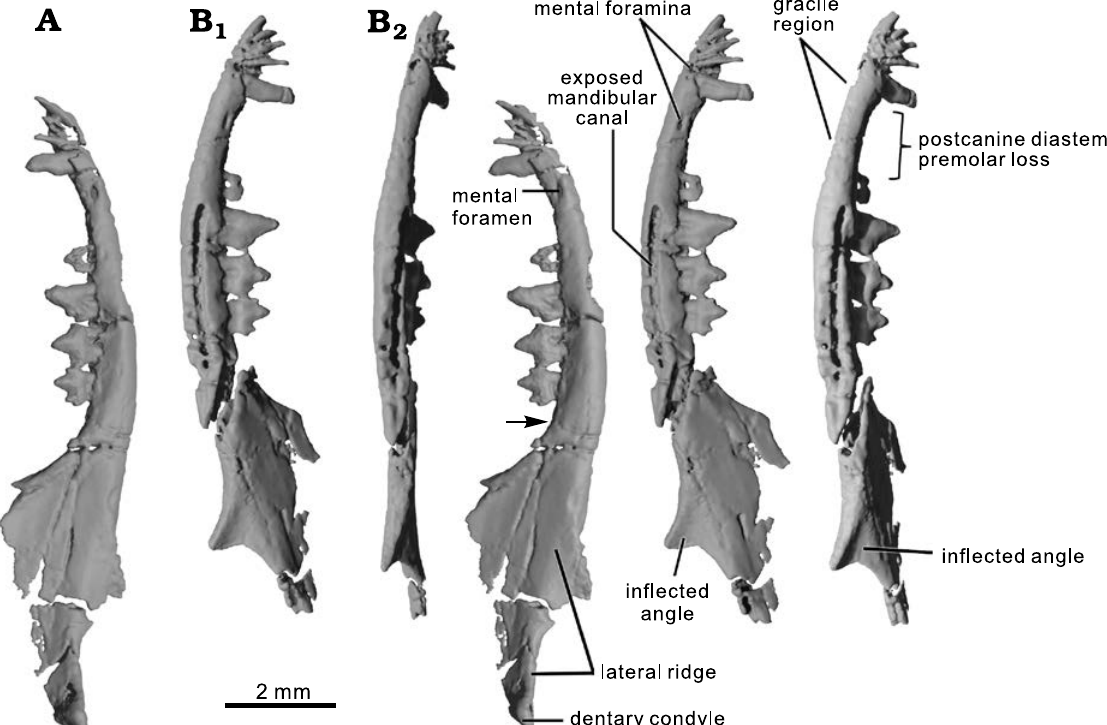
Fig. 2. CT rendering of the mammaliaform Hadrocodium wui Luo, Crompton, and Sun, 2001 (holotype, IVPP 8275) from the Lower Lufeng Formation, Lower Jurassic of Yunnan, China. A . Right mandible in lateral view (stereopairs); solid triangle indicates the retro-molar space. B . Left mandible in lateral (B 1 , stereopairs) and ventral (B 2 , stereopairs)